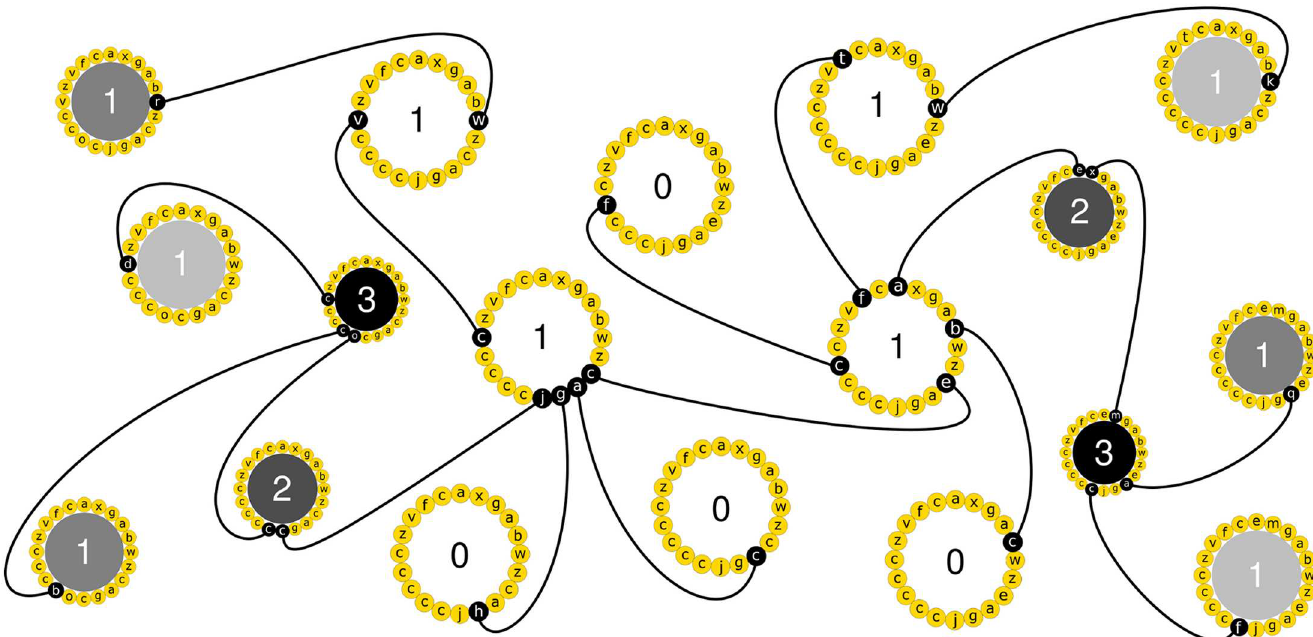
Fig 5. Cartoon summarizing the architecture of the genotype-phenotype map. This subset of a hypothetical genotypespace shows 18 genotypes (large circles). The genotypeof each organism is represented by a circularset of 20 instructions (small letters insidesmall yellow circles). Two genotypes are connectedby a black line if they differ in a single instruction(white letters insidesmall black circles). Only the 1-mutant neighborsthat are relevant for characterizing the genotype-phenotype map are drawn. The size of the circle representingan organism’ genotypeis proportional to the organism’s robustness to mutations (i.e., to singleinstruction changes). Phenotypic complexity of each genotypeis indicatedby gray shadingthat ranges from white (least complex) to black (most complex). Genotypeswith the same phenotype are representedby the same shading. The number of novel phenotypes encodedby the 1-mutant neighborsof each genotypeis indicatedinside the large circles. The cartoon illustratesseveral of our main observations. First, the most robust phenotype (largest circles) is the most abundant,and its genotypes likely form a singlegenotypenetwork (i.e., all pairs of such genotypes can be connectedin genotypespace through a series of point mutationsthat leave the phenotypeintact). Second, the more complex the phenotypeof an organism is (the darker the shading)the larger is its genotypicevolvability (i.e., the number of its 1-mutant neighborswith novel phenotypes), and the smaller its robustness (i.e., the number of its 1-mutant neighborswith the same phenotype). Third, organisms with the least complexphenotype(white circles) can only access the most complexphenotypes (e.g., black circles) through phenotypesof intermediate complexity (gray circles).